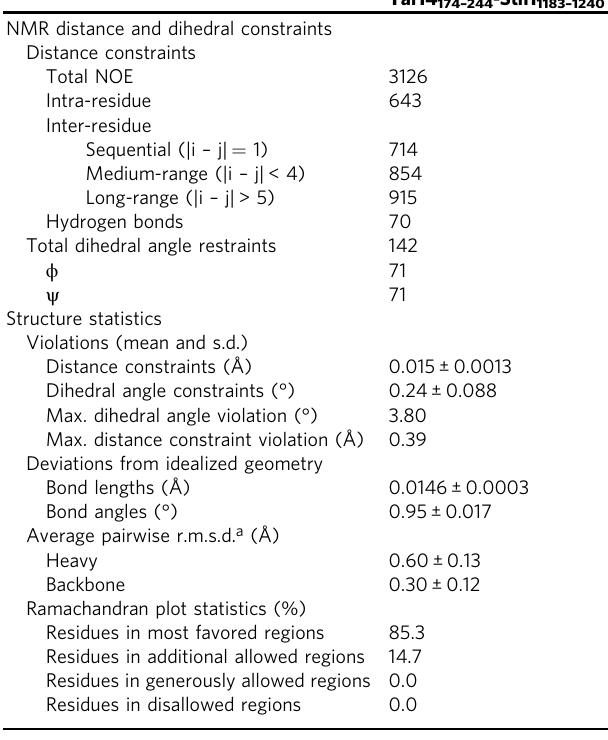
Taf14 174 – 244 -Sth1 1183 –